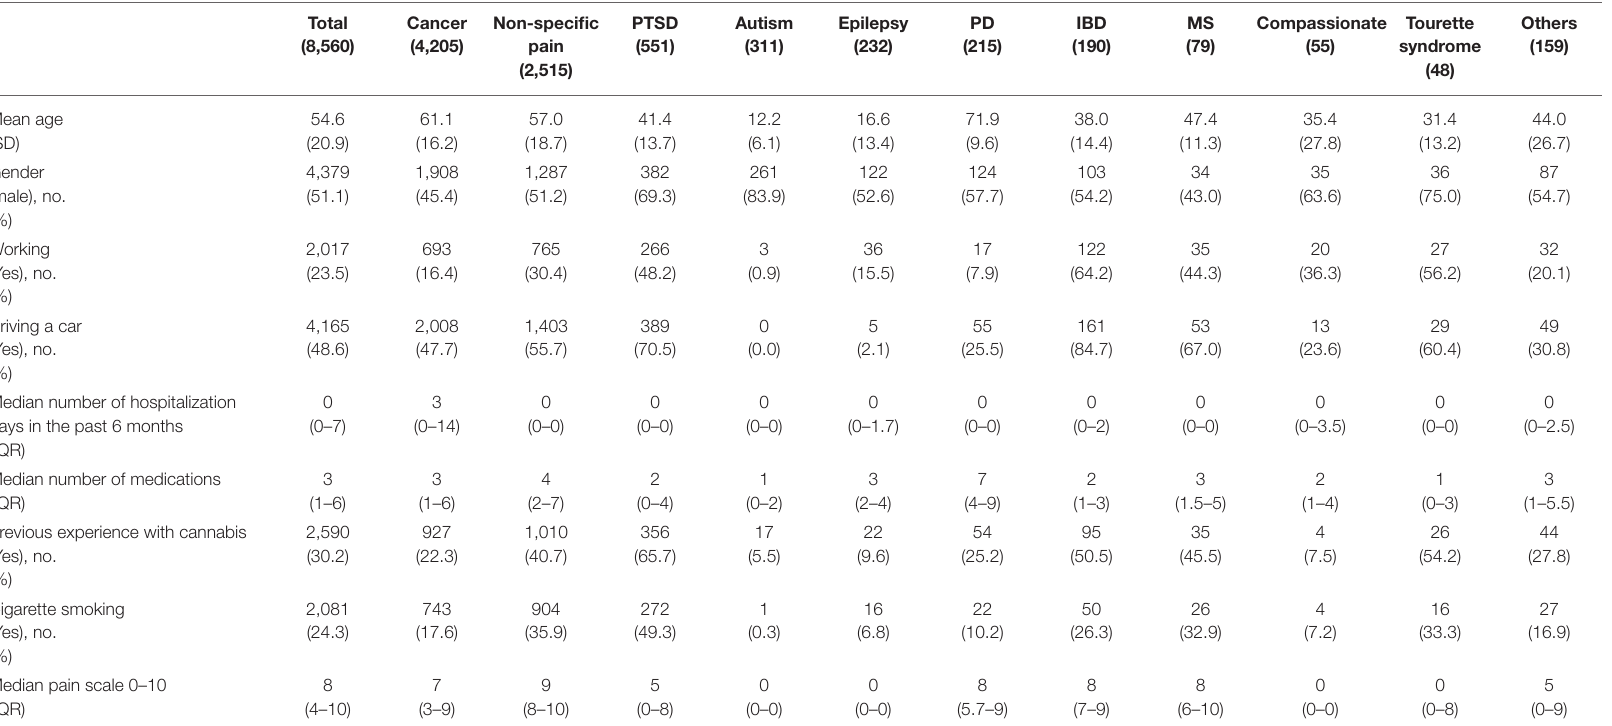
TABLE 1 | Patient’s demographic